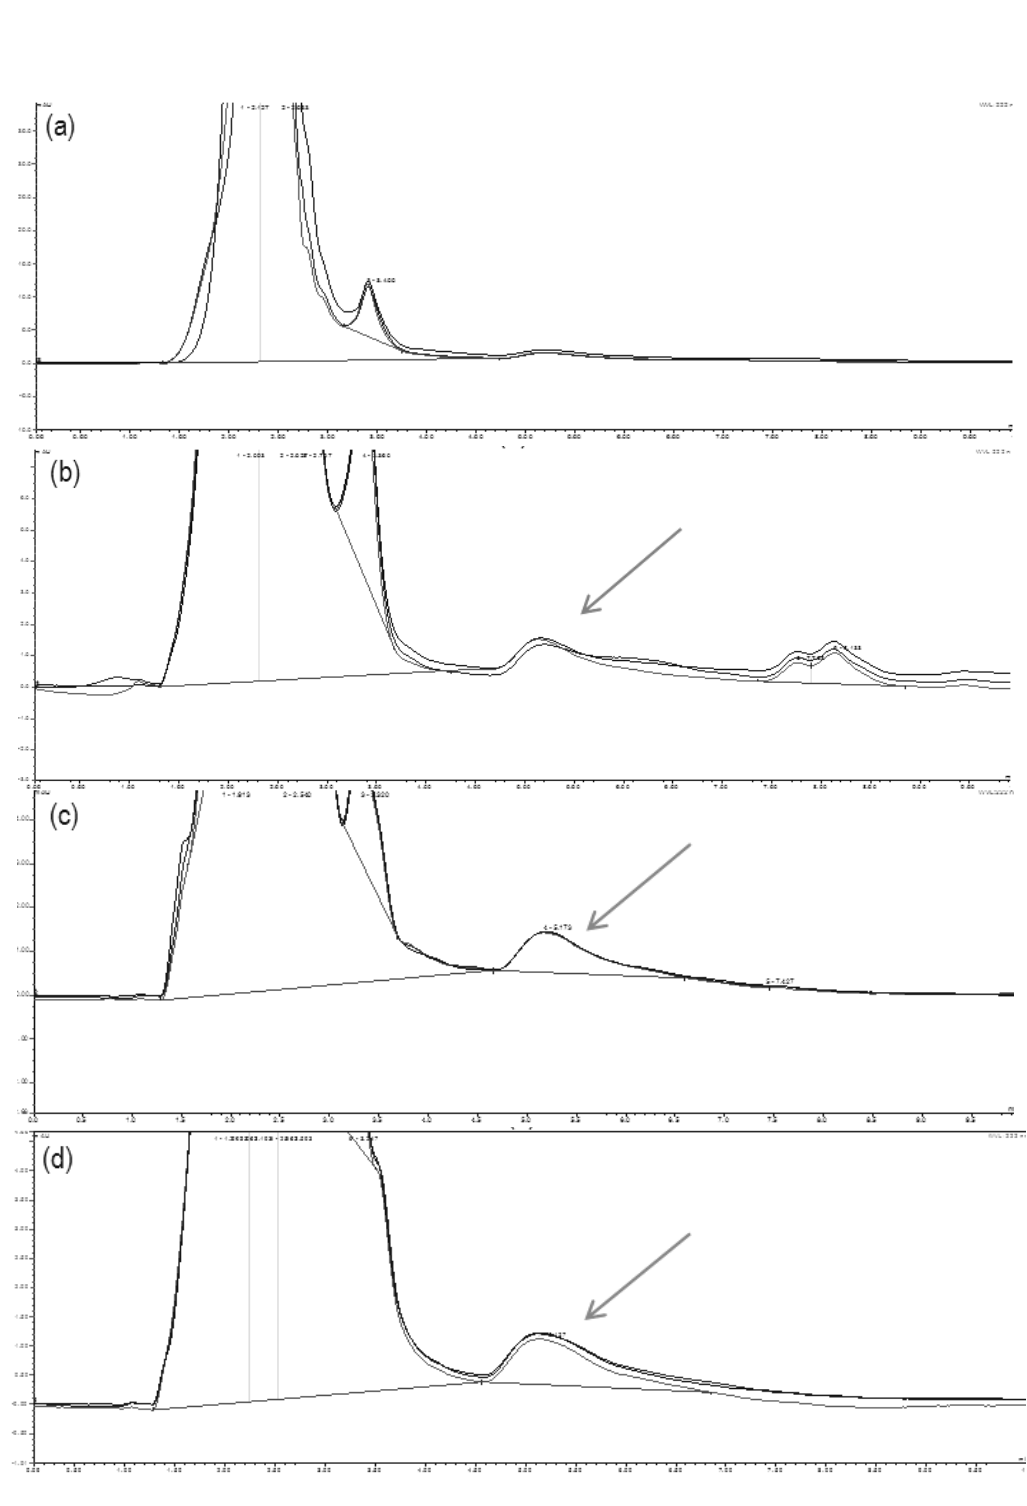
Figure 3. HPLC system of andrographolide in biological matrix using methanol-H 2 O 60:40 (a) plasma blank (b) 1.5 hours after oral administration; (c) 3 hours after oral administration; (d) 5 hours after oral